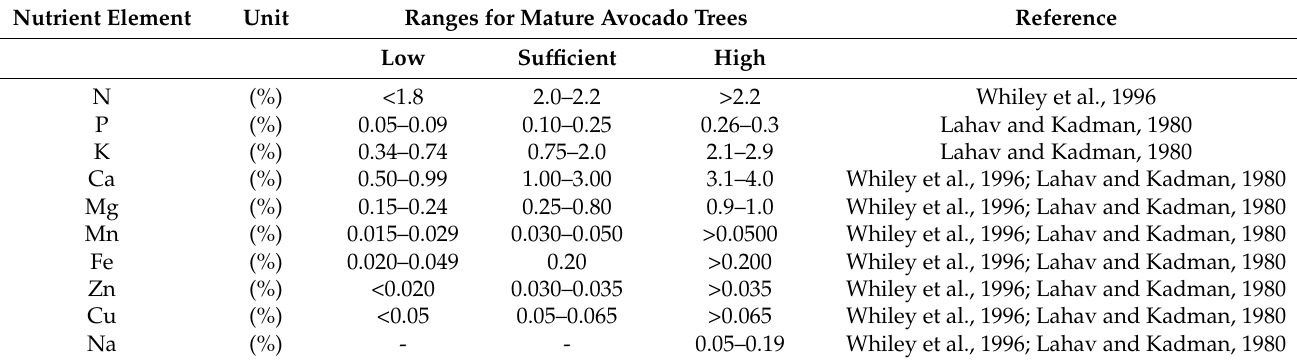
Table 1. Important leaf nutrients categories for avocado production in South Africa.